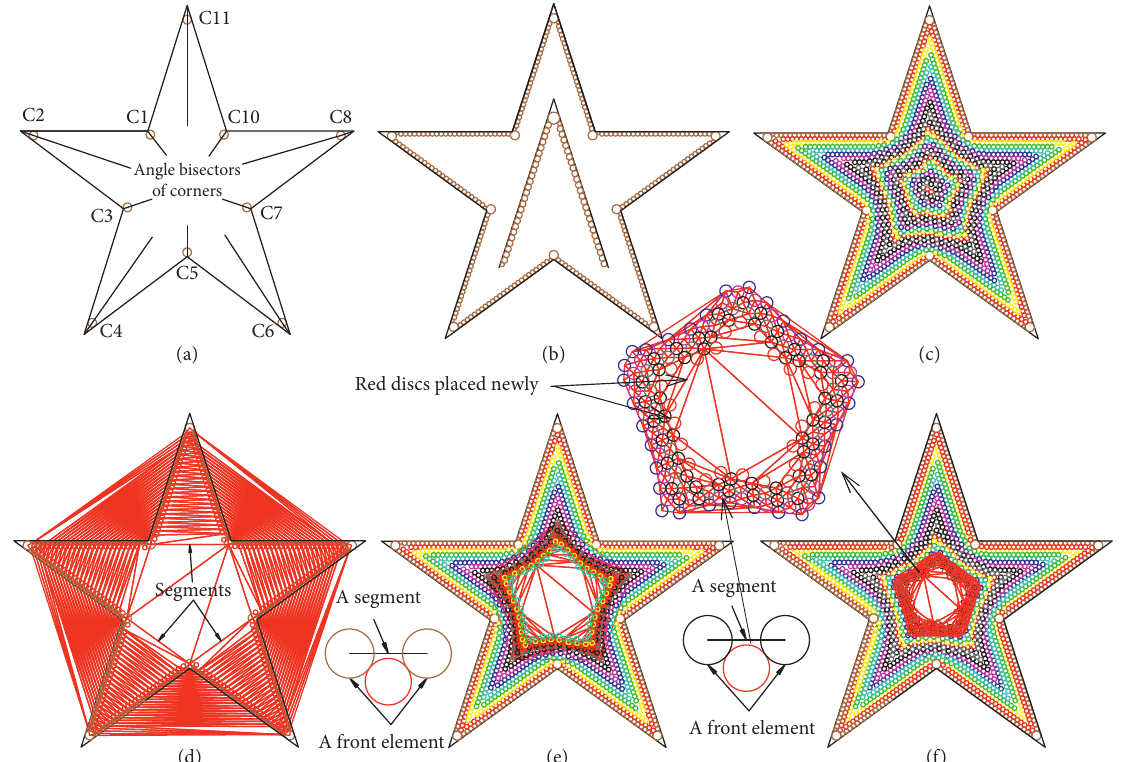
Figure 1: Schematic operations of the algorithm to represent a star-like particle: (a) placement of discs at corners; (b) placement of discs along edges; (c) placement of discs in the domain; (d), (e), and (f) the first, thirteenth, and nineteenth substeps in the third